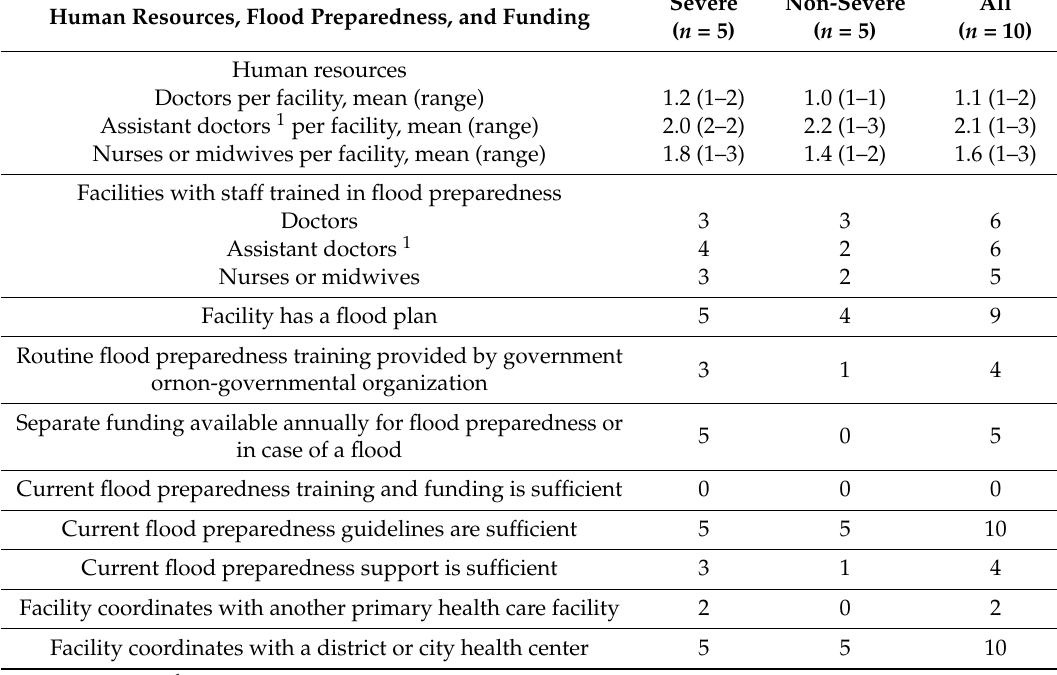
Table 2. Human resources and the availability and sufficiency of flood preparedness training and funding among severely and non-severely flooded primary health care facilities, total n =